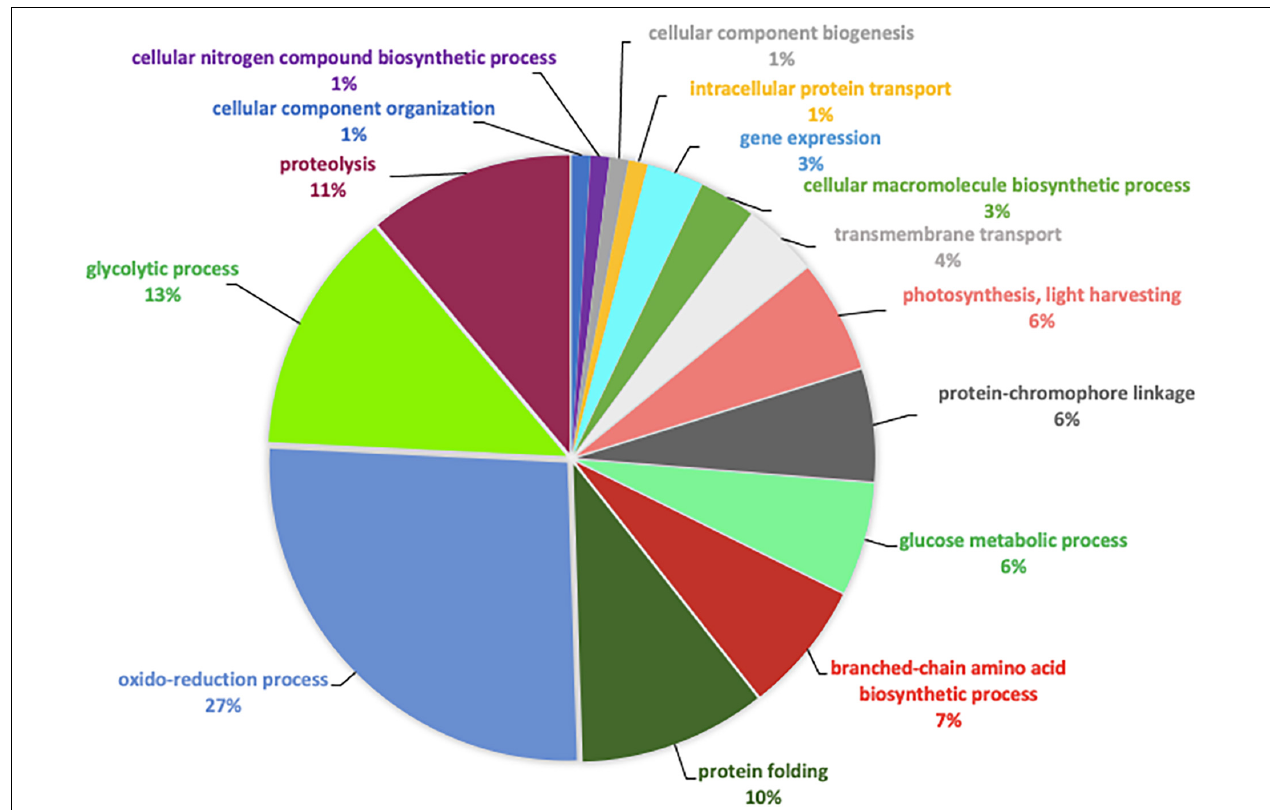
FIGURE 4 | Pie chart representing the biological processes, which are alliterated in the TF pairwise comparison.